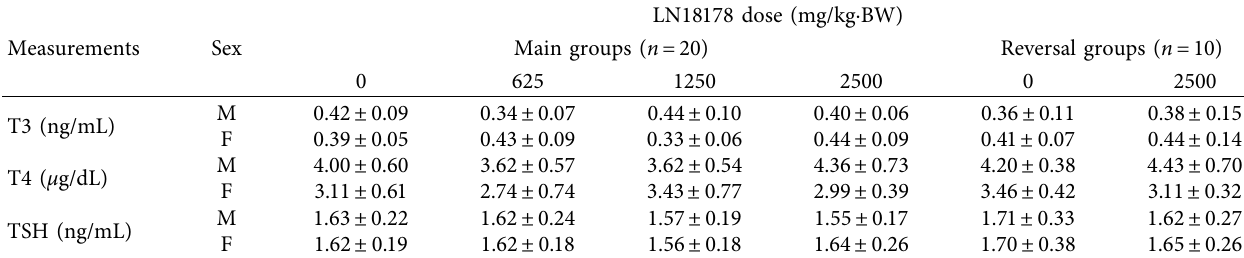
Table 7: Effect of 90-day oral administration of LN18178 on hormones in male and female Wistar rats. Measurements